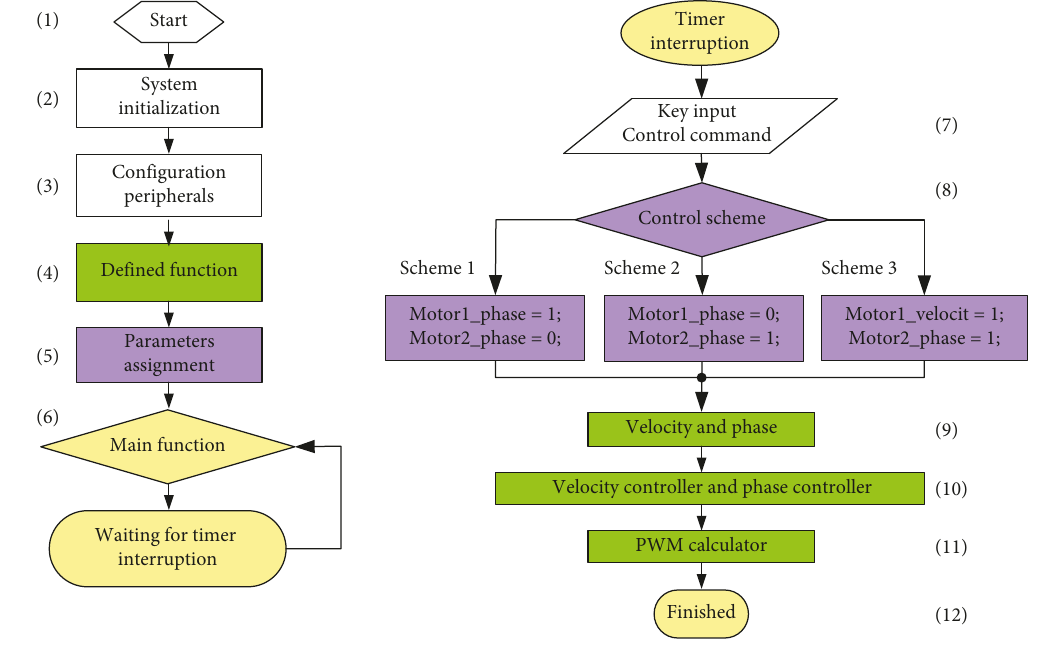
Figure 3: The schematic diagram of software.